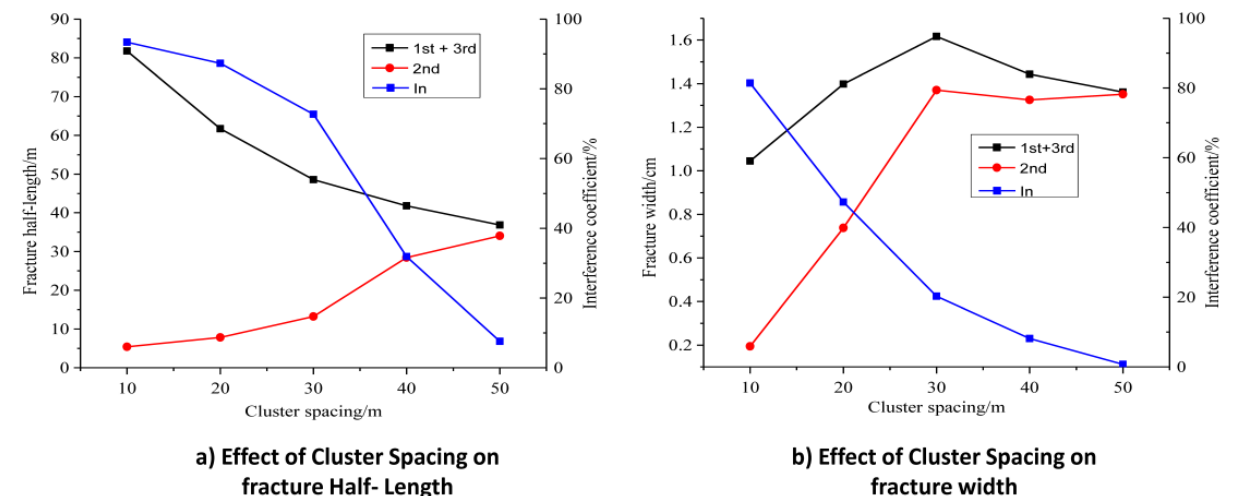
Figure 4: Results of fracture propagation when the cluster spacing is